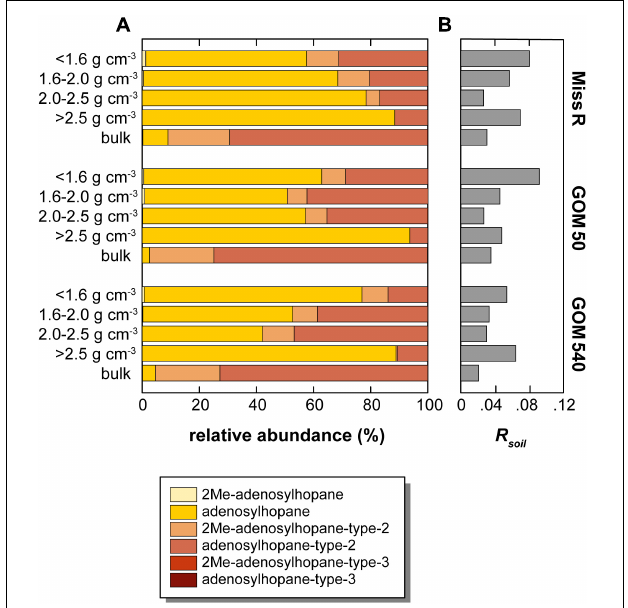
FIGURE 6 | Relative abundance of soil-marker BHPs in density fractions and bulk sediment samples along the Miss R – GOM transect. (A) Relative abundance of soil-marker BHPs, (B) R soil values. Note that relative abundances < 1% are not well resolved graphically, we refer to Supplementary Table S1 for details.